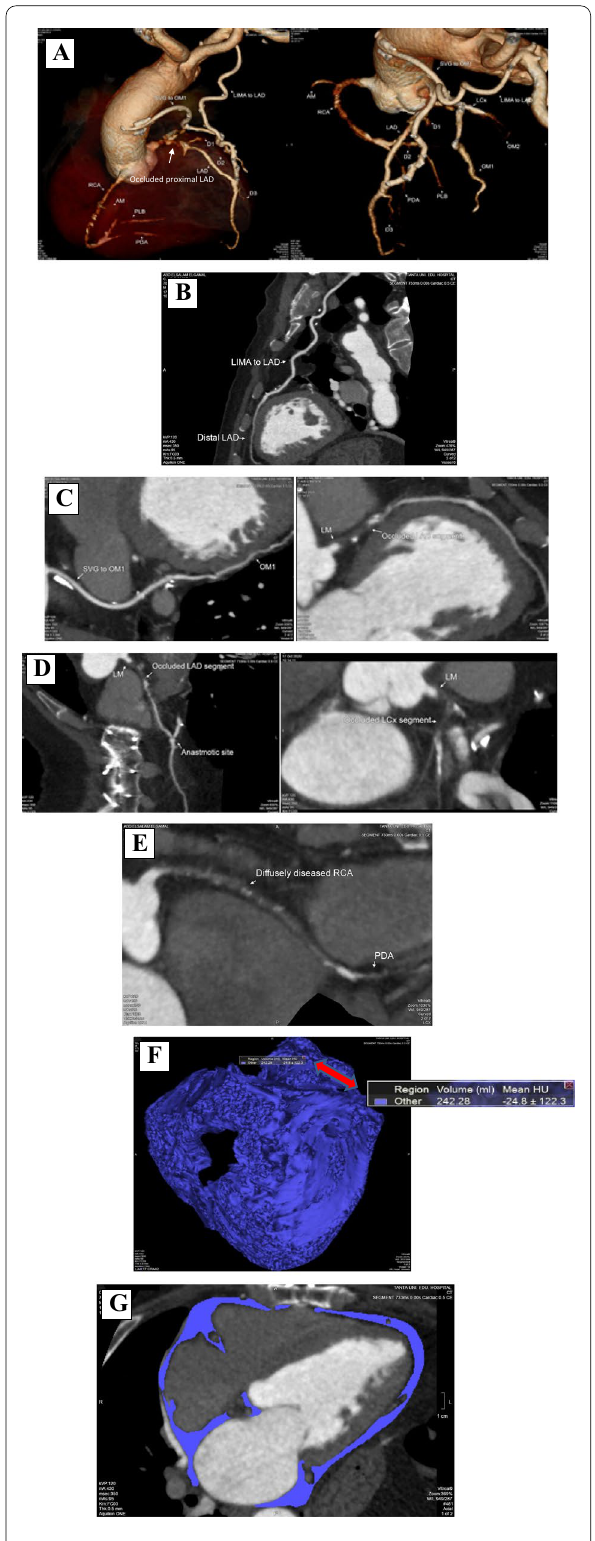
Fig. 4 A – G images: 72‑year‑old male patient (BMI 28), = dyslipidemic, hypertensive and non‑diabetic, and complaining of exertional dyspnea and palpitation. Echocardiography revealed good systolic function (EF 58%), mild mitral incompetence with sclerotic = aortic valve without obstruction, mild tricuspid incompetence and segmental wall motion abnormalities at rest in the form of basal inferior and posterior hypokinesia. A Two different views of 3D volume rendered images, and B Sagittal curved planar reformatted image showing patent LIMA to distal LAD and SVG to OM1 with good opacification of distal LAD and OM1 segments beyond the anastomotic sites, and diffusely diseased RCA with occluded proximal LAD segment. C Two axial curved planar reformatted images showing patent SVG to OM1 without focal stenosis with good filling of the OM artery beyond the anastomotic site, and occluded distal LM proximal LAD with soft plaque. D Two coronal curved planar reformatted images showing occluded distal LM proximal LAD with soft plaque, the distal LAD beyond the anastomotic site is patent and free of significant disease, and occluded distal LM proximal LCx with soft plaque. E Sagittal curved planar reformatted image showing diffusely disease atherosclerotic RCA with patent ostium and totally occluded proximal, mid‑ and distal segments by soft and mixed plaques. F 3D volume rendered image and G 2D axial multiplanar reformatted image showing epicardial fat volume (247 cm 3